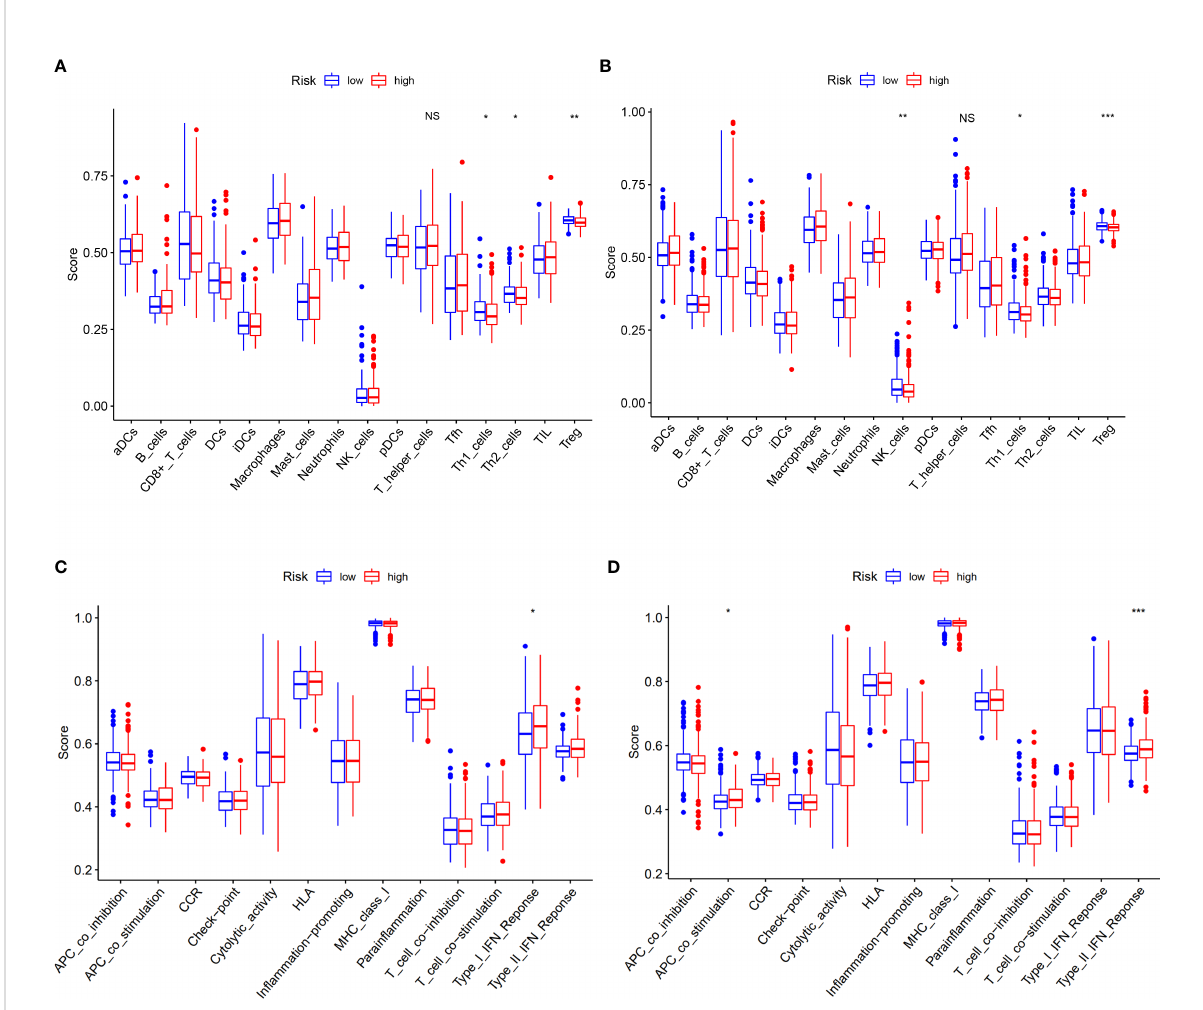
FIGURE 7 Correlation of risk score with immunological features and clinicopathological features. (A, B) Comparison of the enrichment scores of immune cells and immune-related pathways between low- and high-risk group in the TCGA cohort and GEO cohort. (C, D) Comparison of the enrichment scores of immune-related pathways between low- and high-risk group in the TCGA cohort and GEO cohort. NS, no signi fi cance. *p<0.05, **p<0.01,